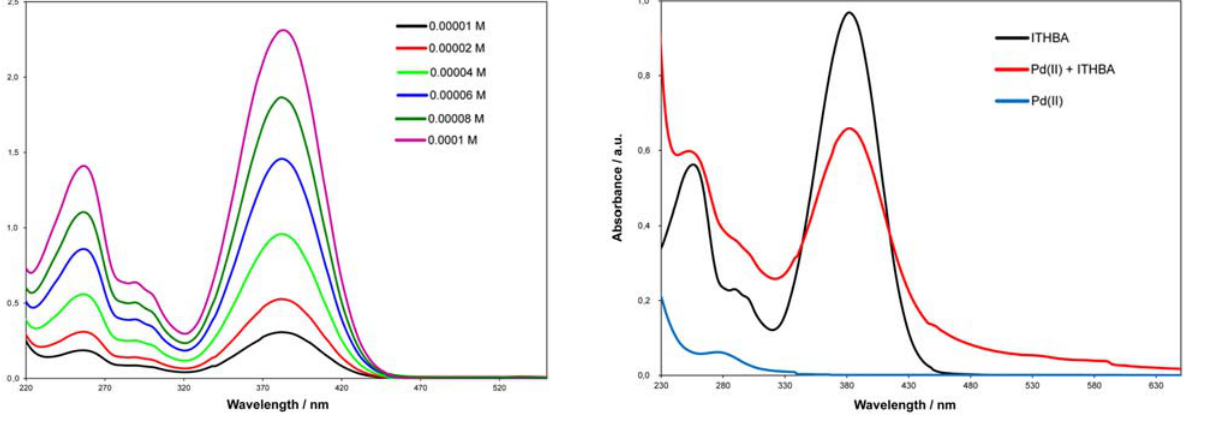
Fig. 3. Absorbance spectra of reagent, Pd(II) and complex Pd(II) with ITHBA